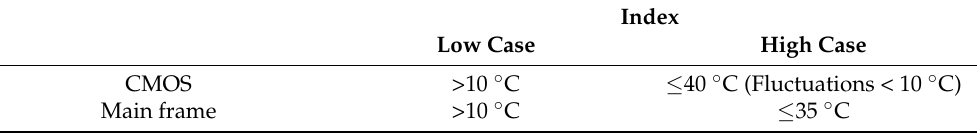
Table 2. Thermal control index of the